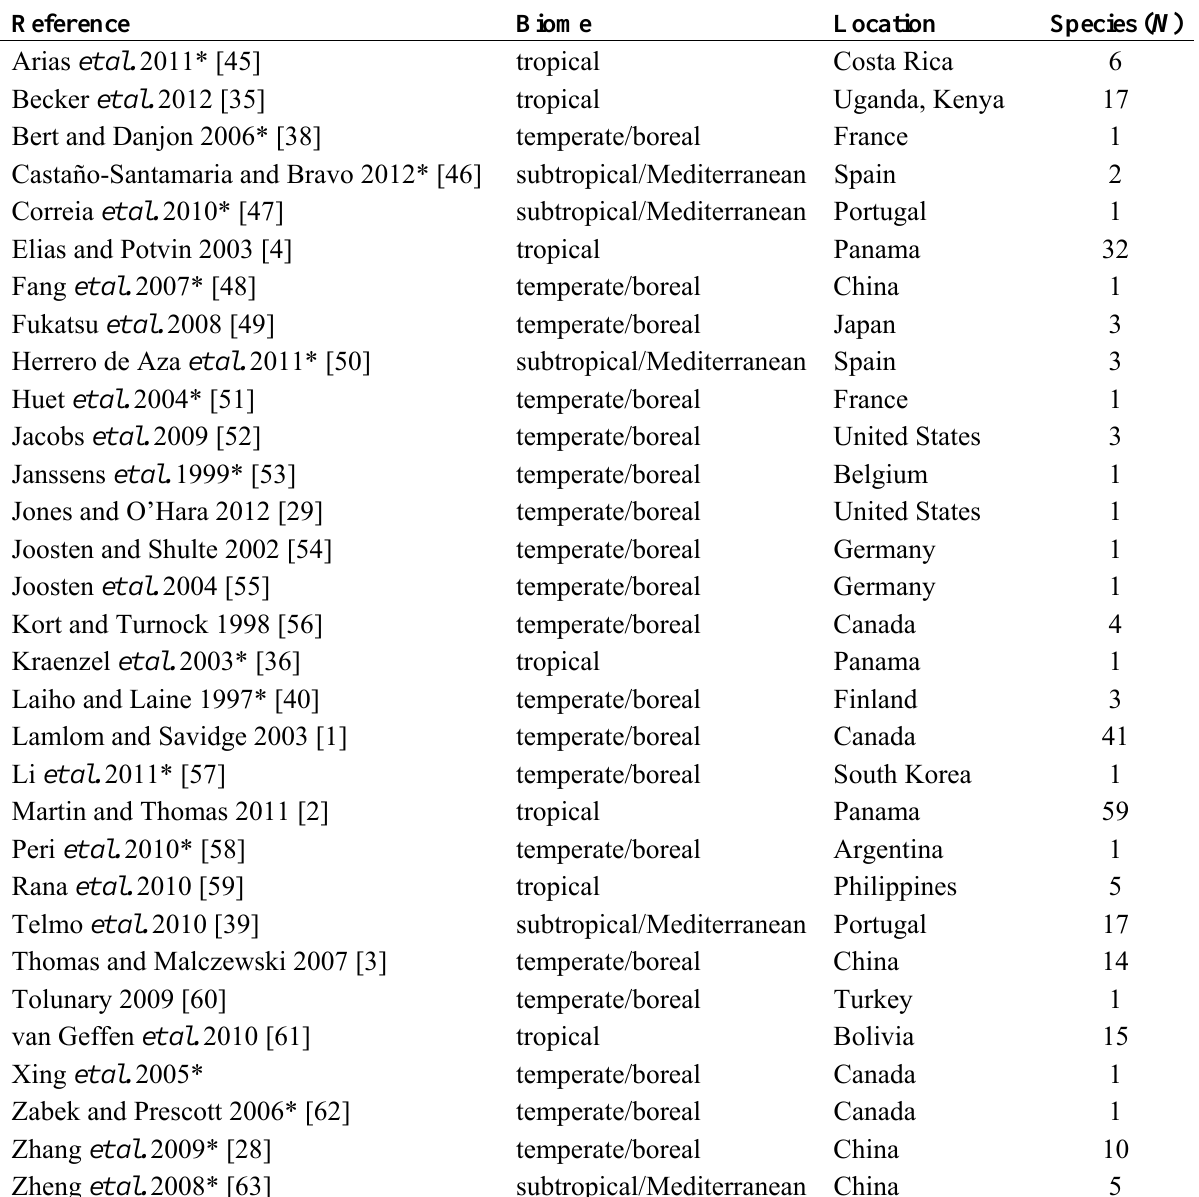
Table 1. Peer-reviewed publications containing species-specific C content data.